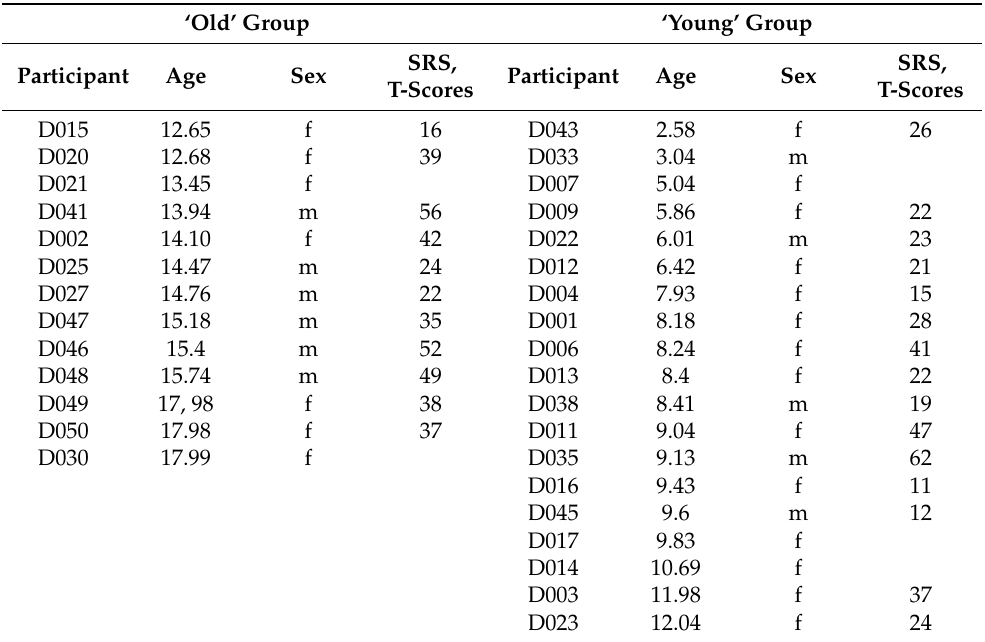
Table A1. Description of comparison groups including age, sex and SRS